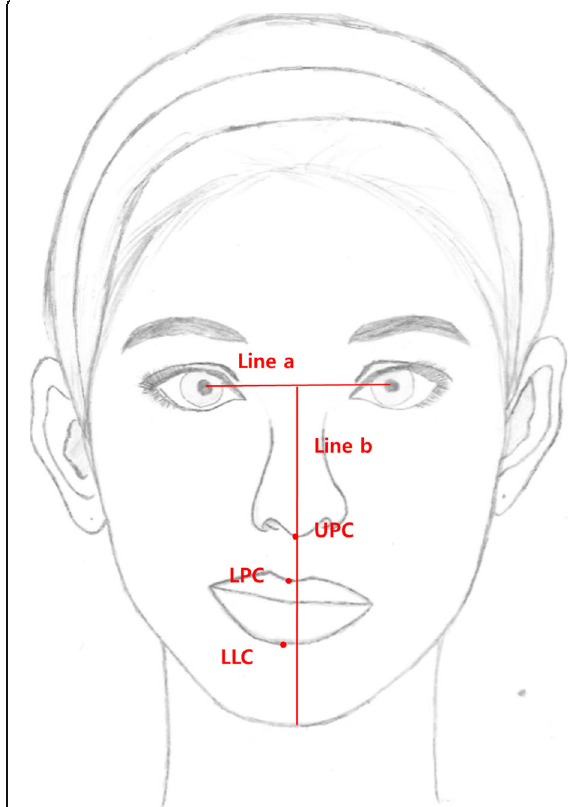
Fig. 2 Reference points and lines for measurement of the philtrum position deviation on a frontal view of a clinical photograph. Line a: interpupillar line as the horizontal reference line. Line b: facial midline perpendicular to line a and through the interpupillar midpoint. UPC: upper philtrum center as the midpoint of both the upper end of the philtrum ridge just below the columella. LPC: lower philtrum center as the midpoint of both the lower end of the philtrum ridge just above the vermillion border. LLC: lower lip center as the midpoint of the lower lip between both mouth corners